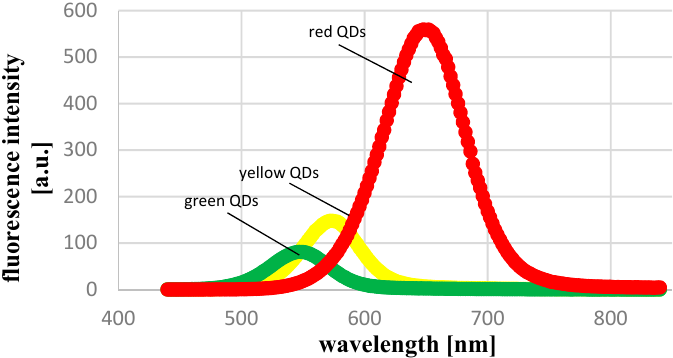
Figure 2 . Fluorescence spectra of MSA-capped CdTe QDs.